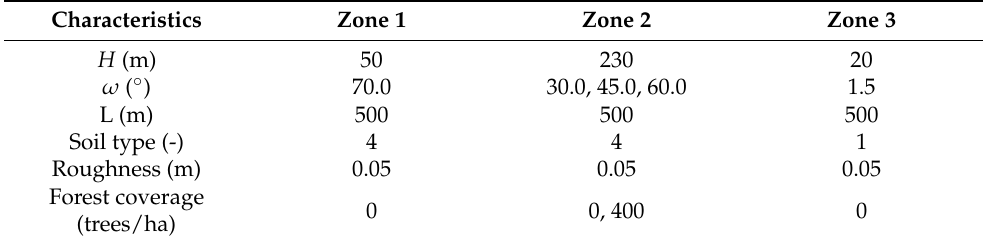
Table 3. Geometrical and physical characteristics of the synthetic slopes. See also Figure 3 for the meaning of symbols. Soil 4 refers to a compact soil with large rock fragment; soil 1 refers to a fine soil material [27].